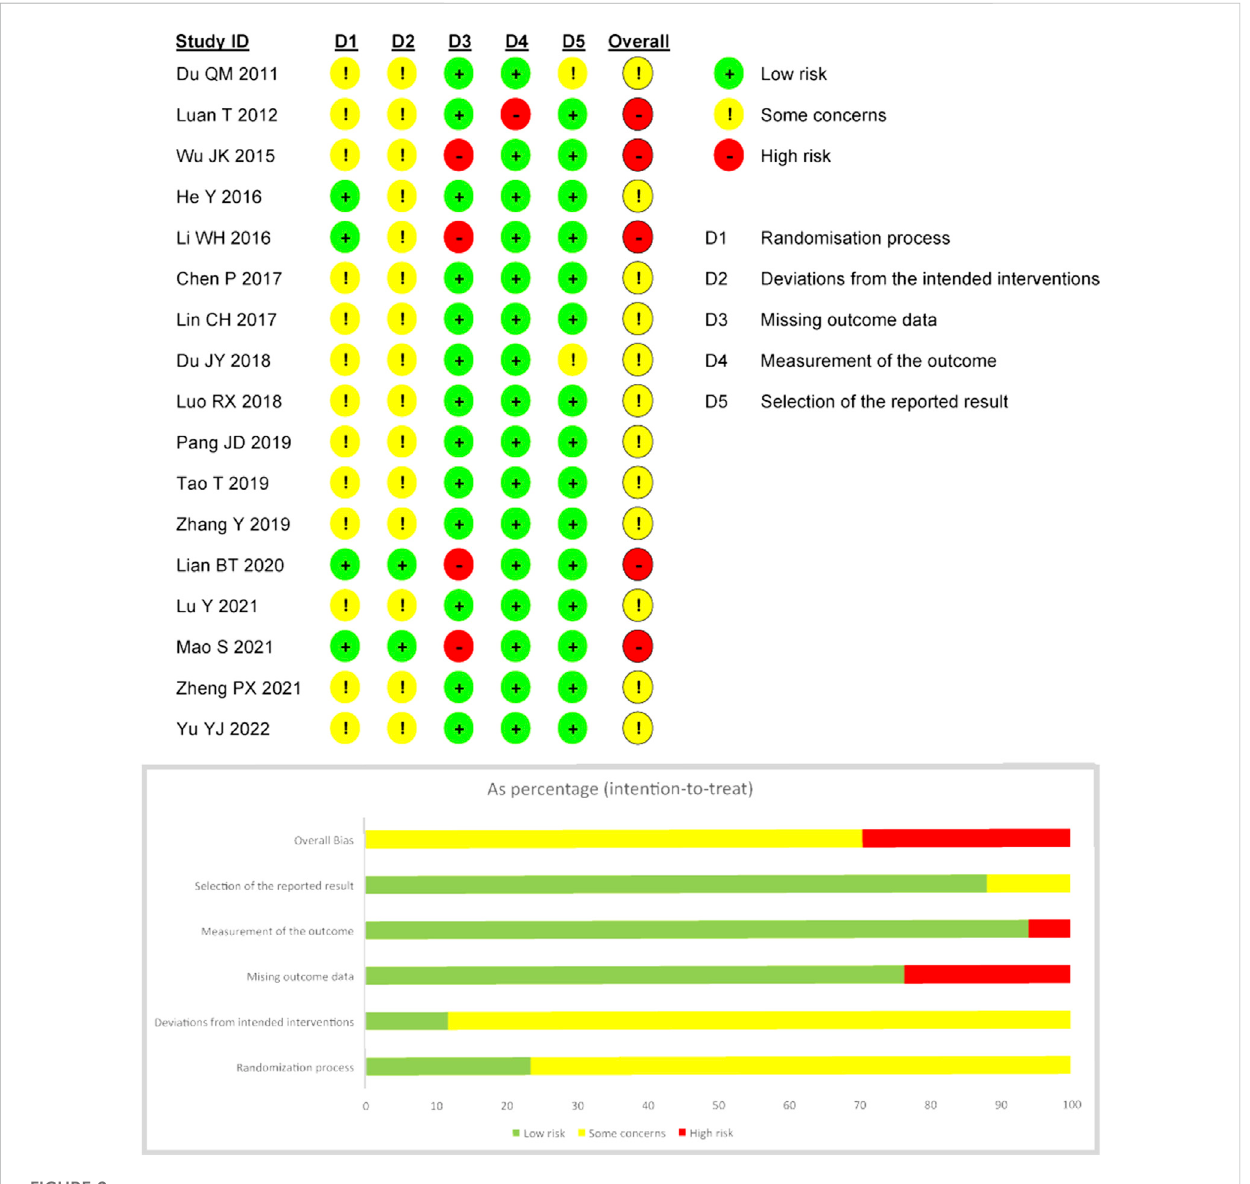
FIGURE 2 Risk of bias